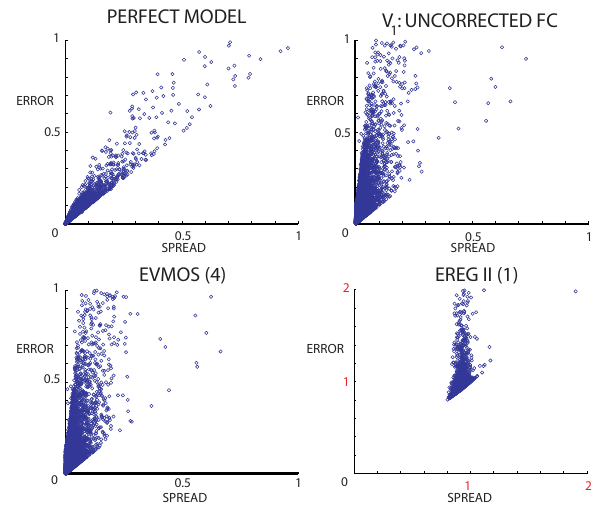
Fig.13. Scatterplotofspreadagainsterrorof10.000ensemblesat t =2 . Thespreadisthesquarerootofthe Fig. 13. Scatterplot of spread against error of 10000 ensembles at ensemble variance and the error is the ensemble average of u r . The results are generated using the Lorenz t = 2. The spread is the square root of the ensemble variance and the modelwithlargemodelerror( (cid:14)r =10 (cid:0) 2 )usingensemblesof 500 memberseach. Theperfect-modelresultis error is the ensemble average of u r . The results are generated using obtainedwithoutmodelerror. NotethescaleoftheEREGIIplotwhichhasascalewhichistwiceaslarge. the Lorenz model with large model error ( δr = 10 − 2 ) using ensem- bles of 500 members each. The perfect-model result is obtained without model error. Note the scale of the EREG II plot which has a scale which is twice as